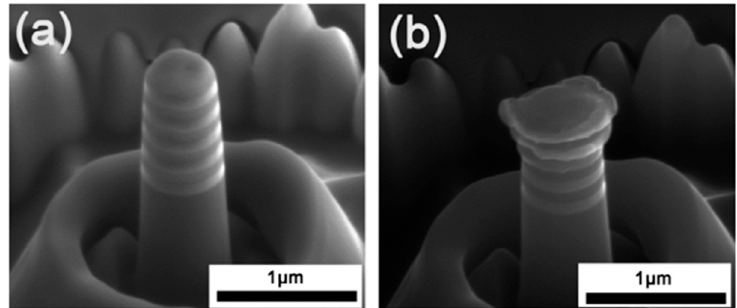
Figure 23. Pre-loading ( a ) and post-loading ( b ) scanning electron micrographs of micropillars of the Mg/Ti multilayer with h = 100 nm. The post-loading image indicates that under compression, the Mg layers (the layers of bright contrast) have been squeezed or extruded out between the mechanically rigid Ti layers [32].